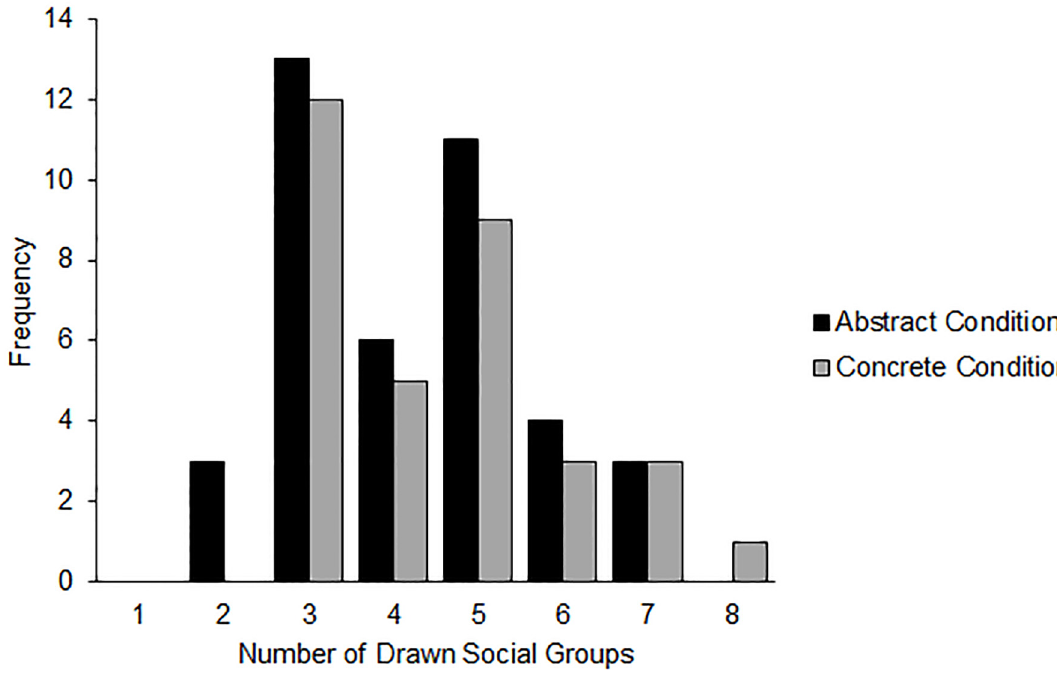
Fig 3. Distribution of drawn social groups by construal mindset condition (Study